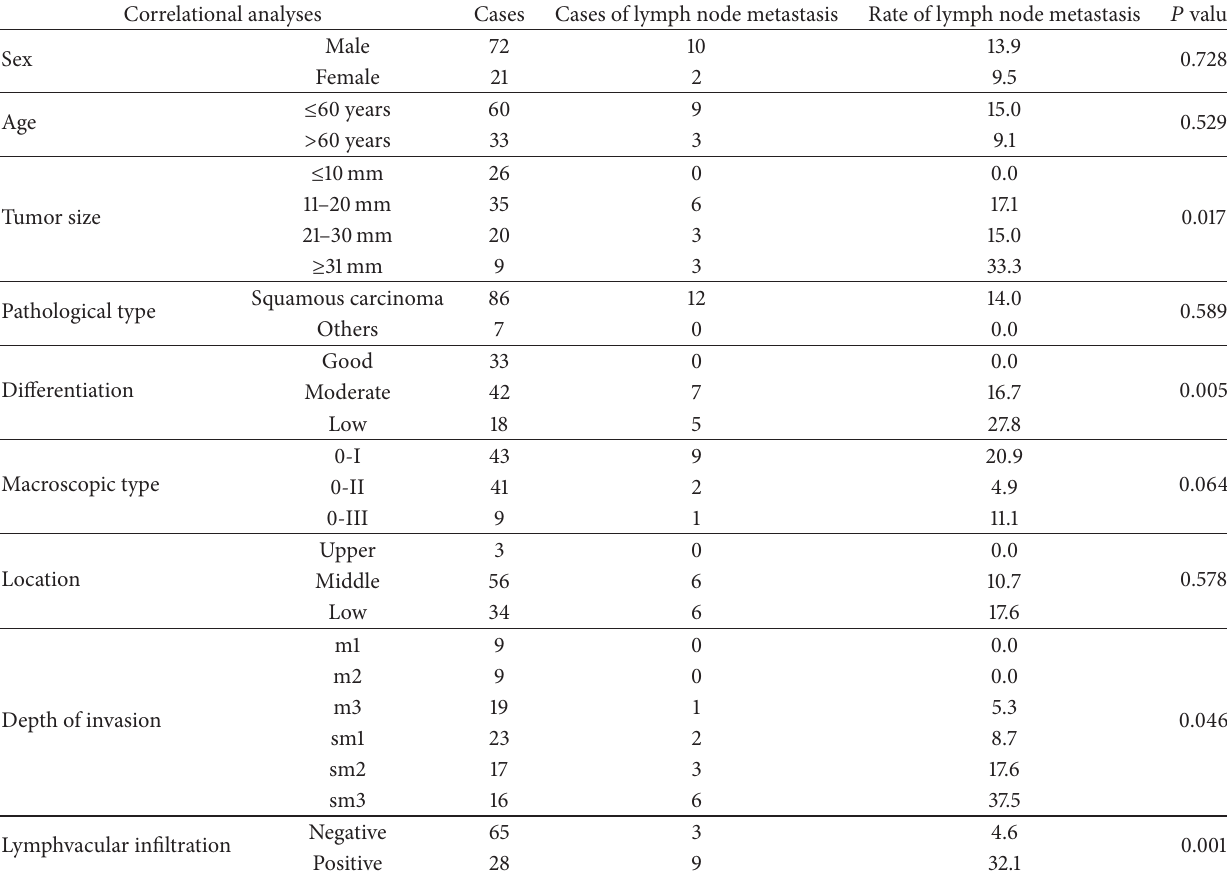
Table 1: Relationship between clinicopathological factors and lymph node metastasis.